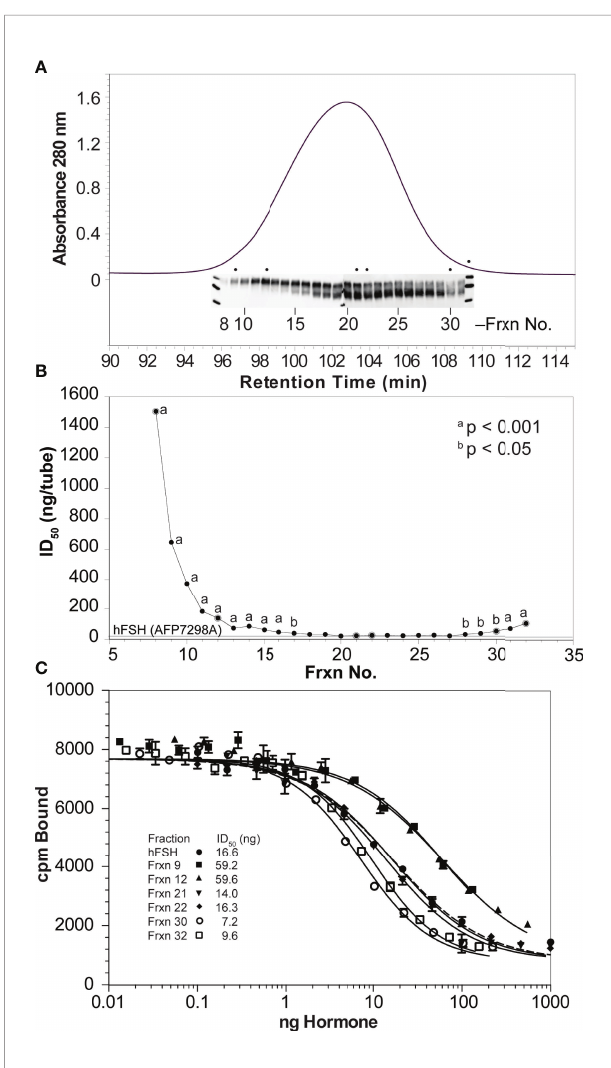
FIGURE 4 | High resolution gel fi ltration chromatography of immunopuri fi ed hFSH. (A) The chromatogram shows the results of fractionating 10